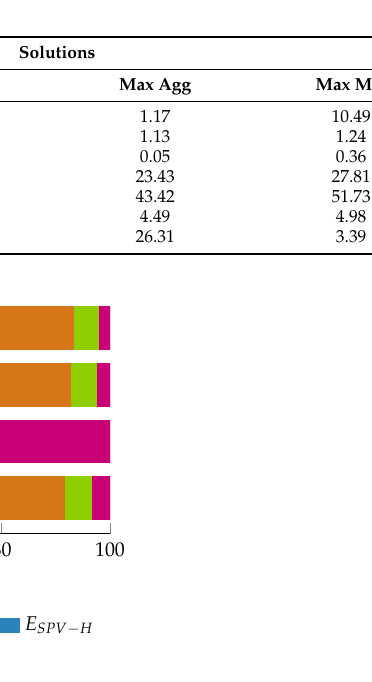
Figure 8. Distribution of energy sources supplying the households.